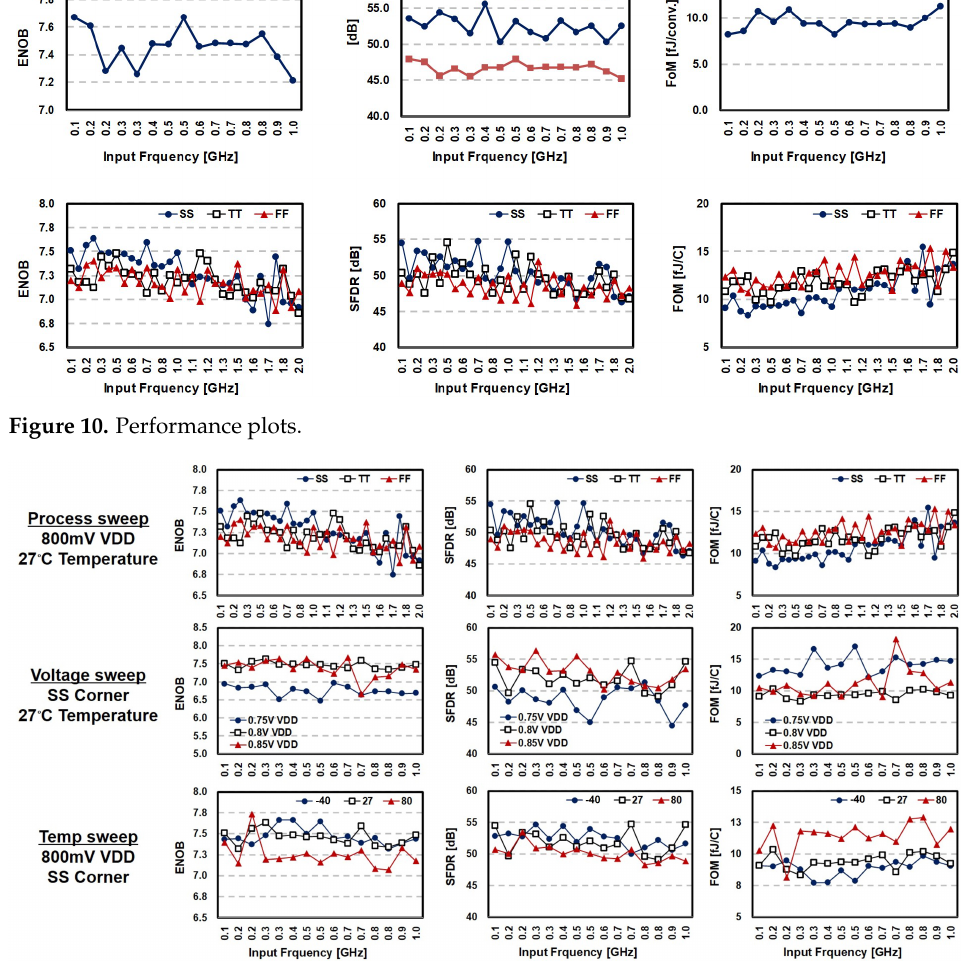
Figure 11. Sensitivity check over PVT